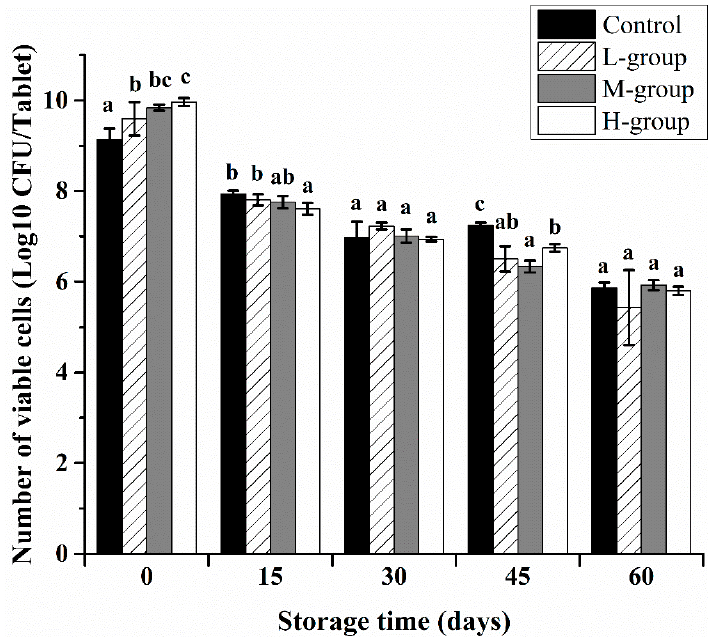
Figure 1. Viability of lactobacilli in different kinds of lactobacilli effervescent tablets stored for 0, 15, 30, 45 and 60 days at 25 °C. All data show the means ± SD. At the same storage period, different letters 45 and 60 days at 25 ◦ C. All data show the means ± SD. At the same storage period, di ff erent letters indicate a significant difference. indicate a significant di ff